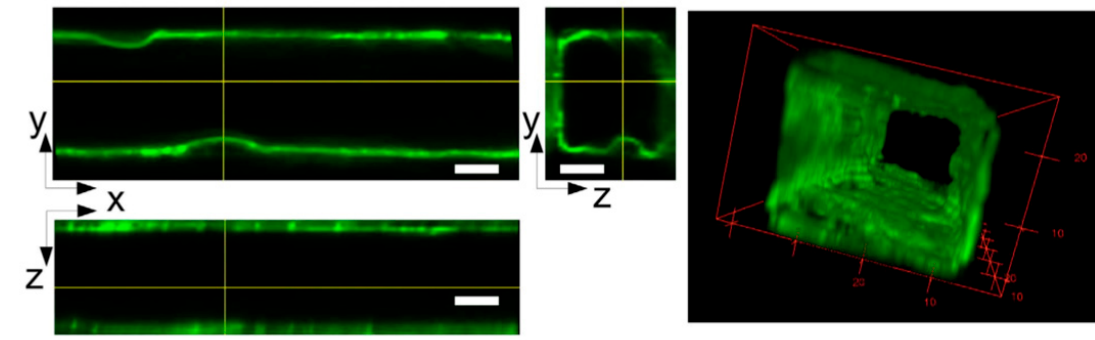
Figure 3. Confocal images depicting the wheat germ agglutinin-tagged ESL in three planes (left) with a 10 µ m scale bar. On the right is a 3D rendering of the ESL. Adapted with permission from Tsvirkun et al. [95].